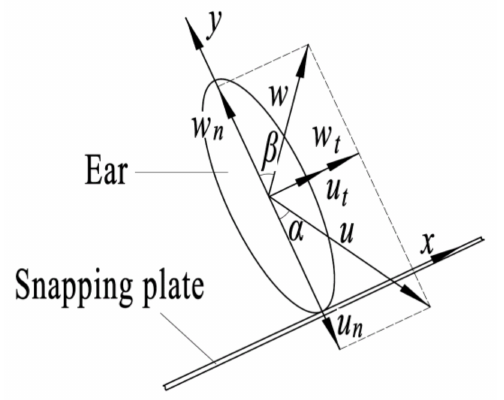
Figure 1. The collision between ear and snapping plate: x — x axis of the coordinate system; y — y axis of the coordinate system; w —the speed of the ear after the collision; w t —the component velocity of w in the x axis direction; w n —the component velocity of w in the y axis direction; β —the angle between w and w n ; u —the speed of the ear before the collision; u t —the component velocity of u in the x axis direction; u n —the component velocity of u in the y axis direction; α —the angle between u and u n . In order to facilitate the analysis, the rotation of the ear was ignored during the collision process, the ear was simplified into an ellipsoid, and the common normal line of the contact between the ear and the snapping plate passed through the ear